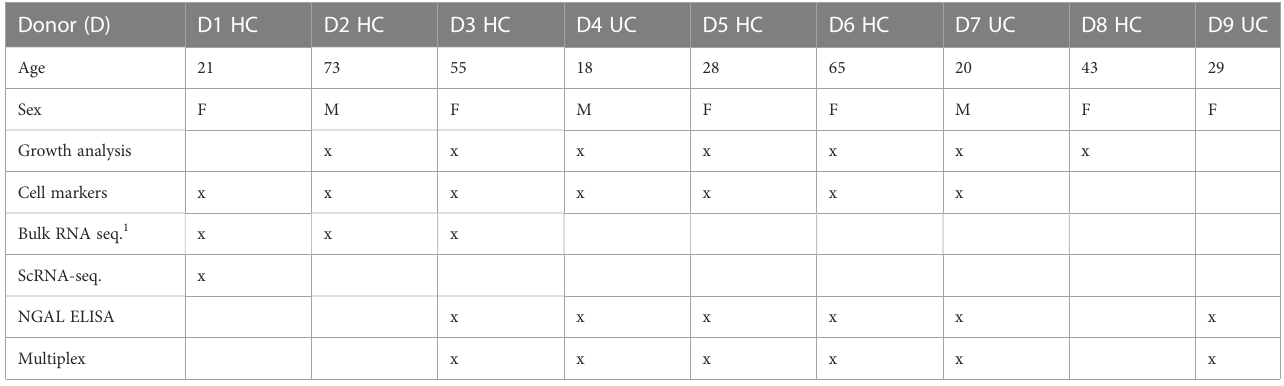
TABLE 1 Colonoid donor characteristics and experimental